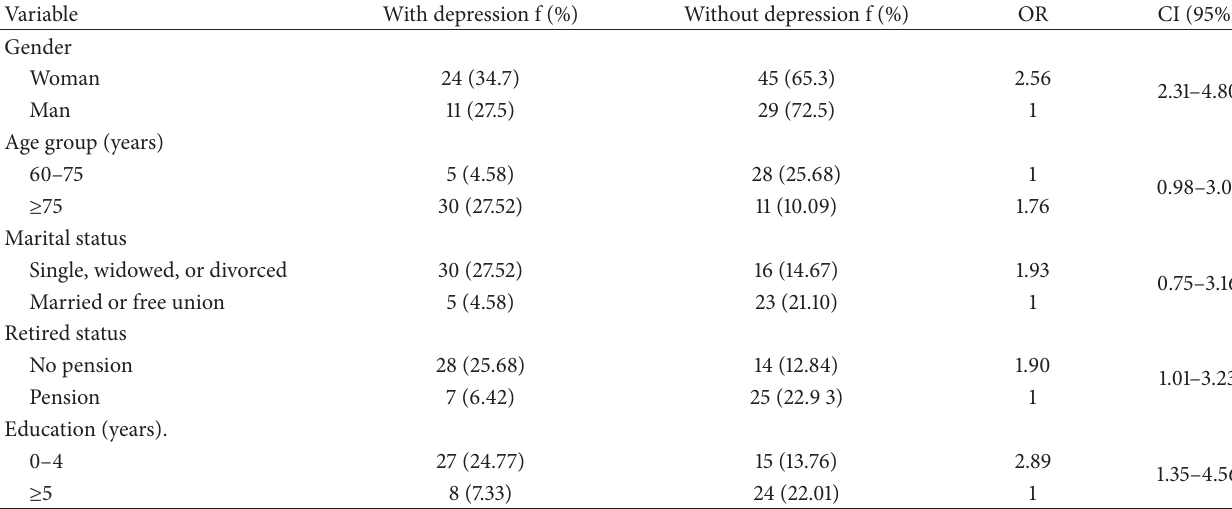
Table 3: Association between sociodemographic characteristics and depression ( 𝑛 = 109 older adults with dementia).